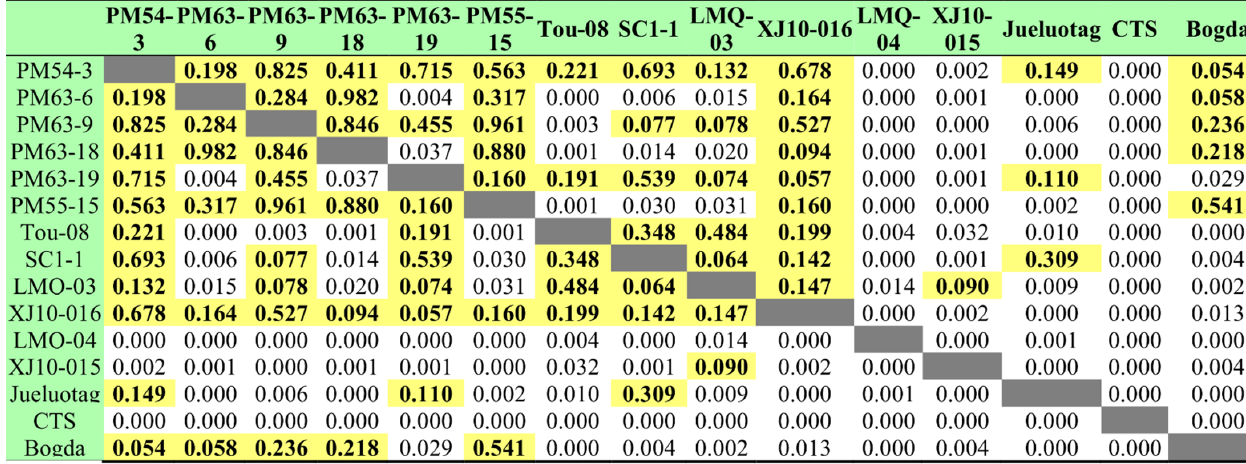
Figure 13. KS P-value tests for Cretaceous samples (same derived data as those in Figure 12; 95% confidence that the two groups were not statistically different; p -values had to exceed 0.05; comparisons between units with p -values greater than 0.05 are highlighted in yellow).